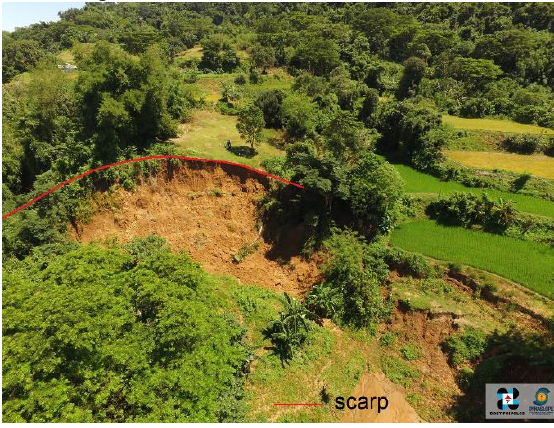
Figure 3 . Major landslide scarps in Brgy. Immuli, Pidigan, Abra (PHIVOLCS